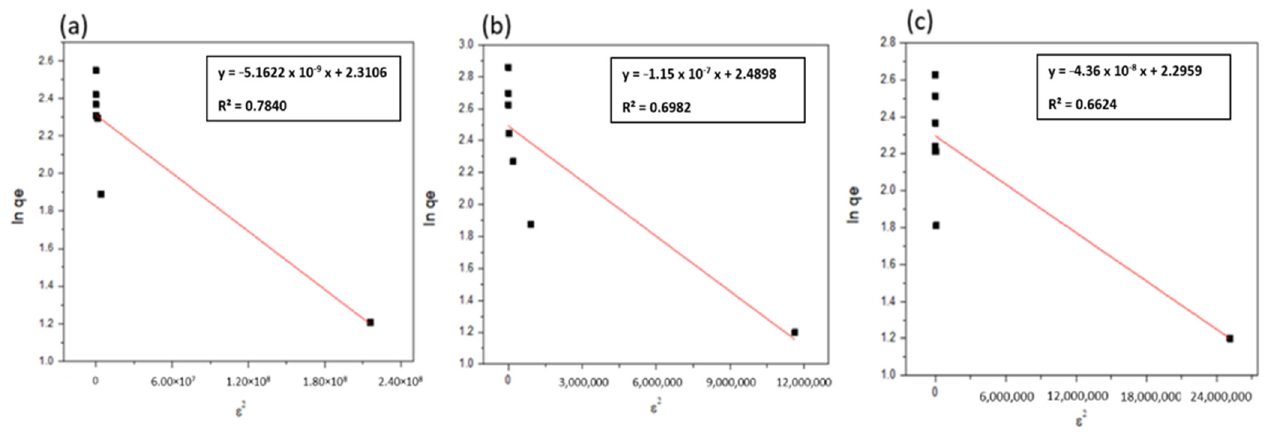
Figure 14. Dubinin–Radushkevitch (D–R) model of thorium adsorption onto ( a ) NZ, ( b ) PZ, and ( c ) SZ. ( c )